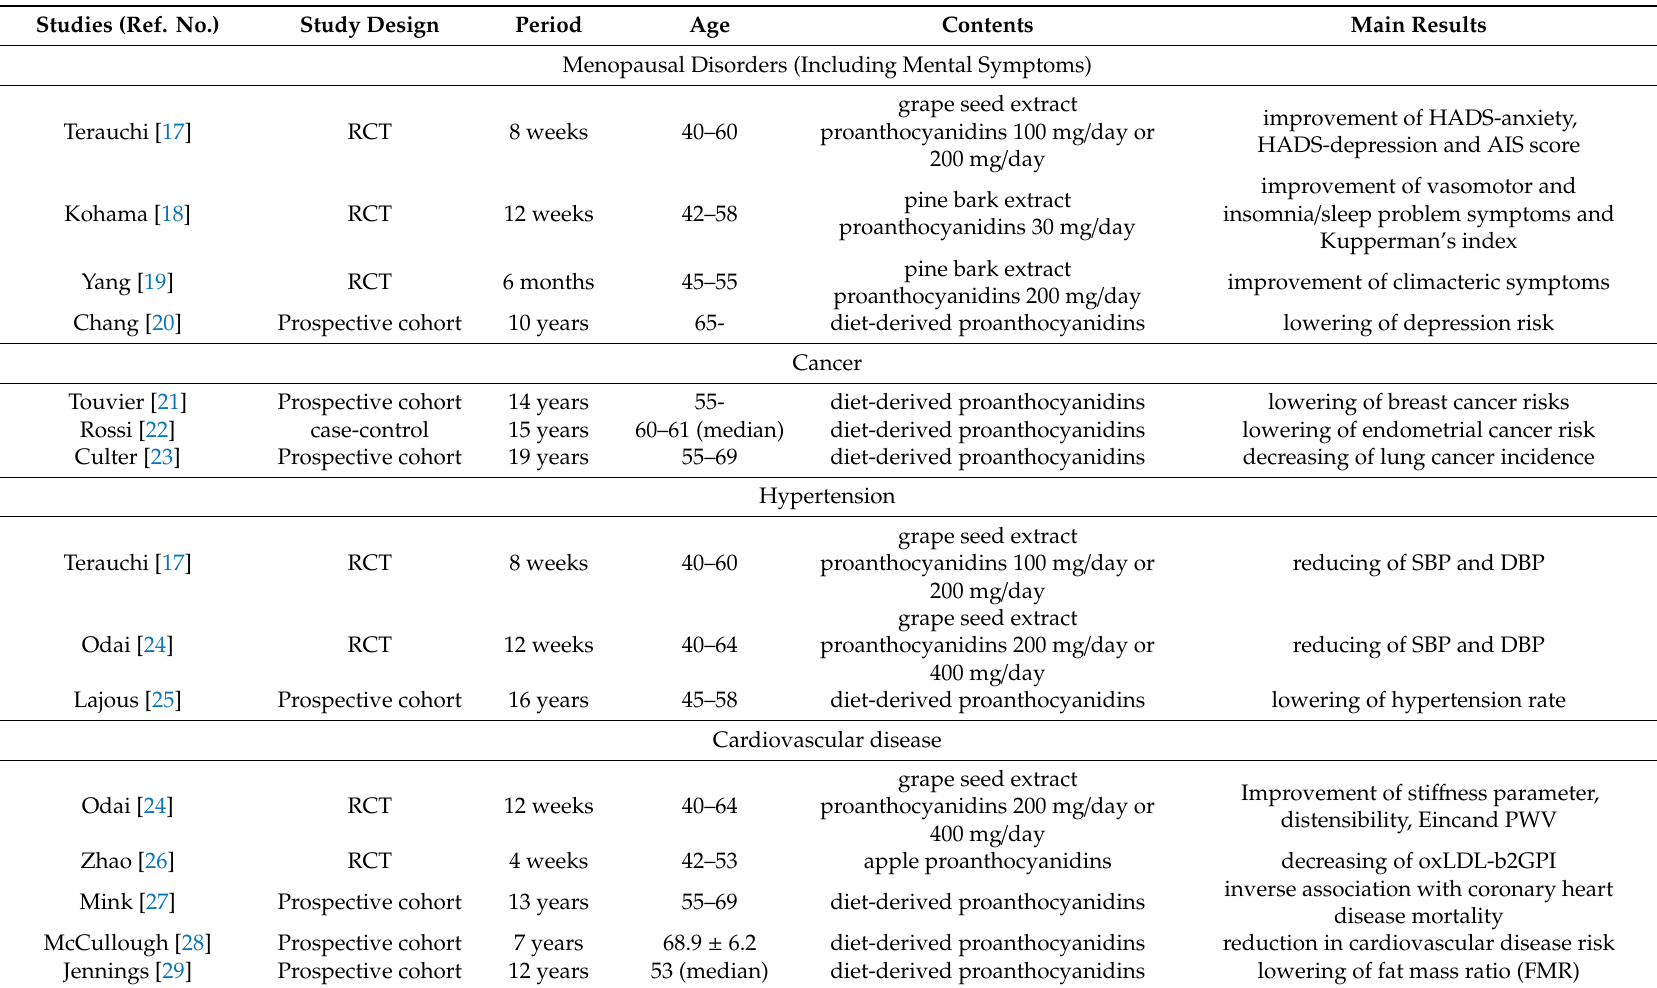
Table 1. A summary of current evidence of studies regarding the e ff ects of proanthocyanidins for middle-aged and elderly women. Studies (Ref.